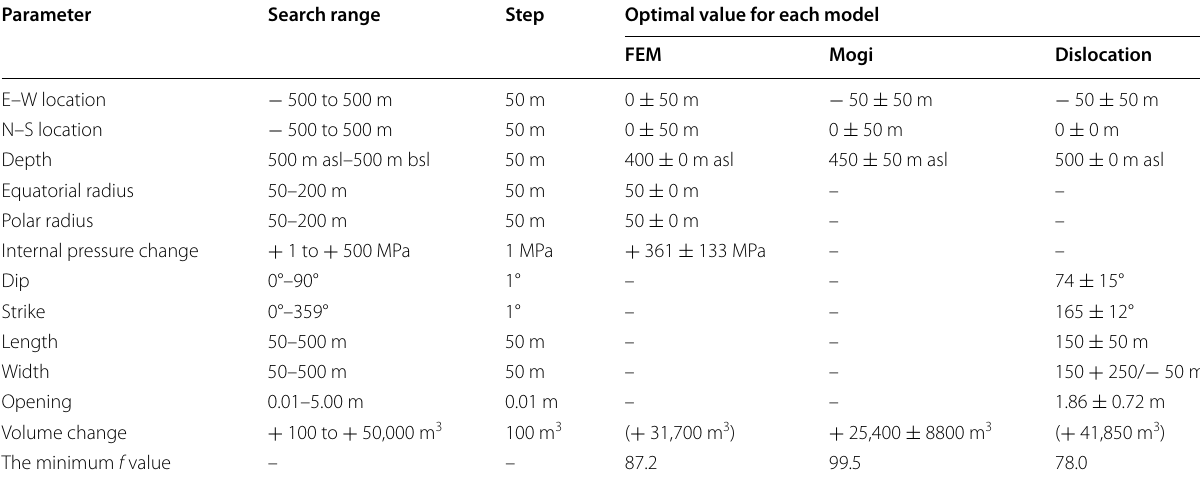
The origin of the horizontal coordinate is set at Shin-dake crater (130.21539°E, 30.44593°N). The position of the dislocation model is at the center of the top edge of the fault. The dip is clockwise from the horizontal and the strike is clockwise from the north. The uncertainties are the 95% confidence intervals estimated from the F test (Árnadóttir and Segall 1994)